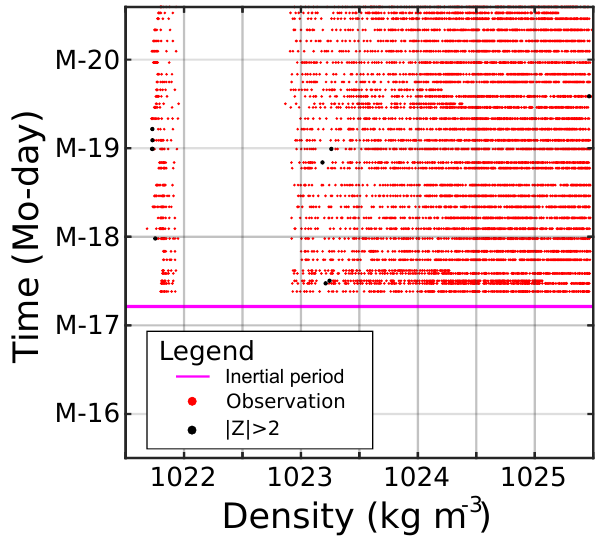
Figure 10. Same as Fig. 9 for LDB, with | Z | < 2 observations plot- ted in red.